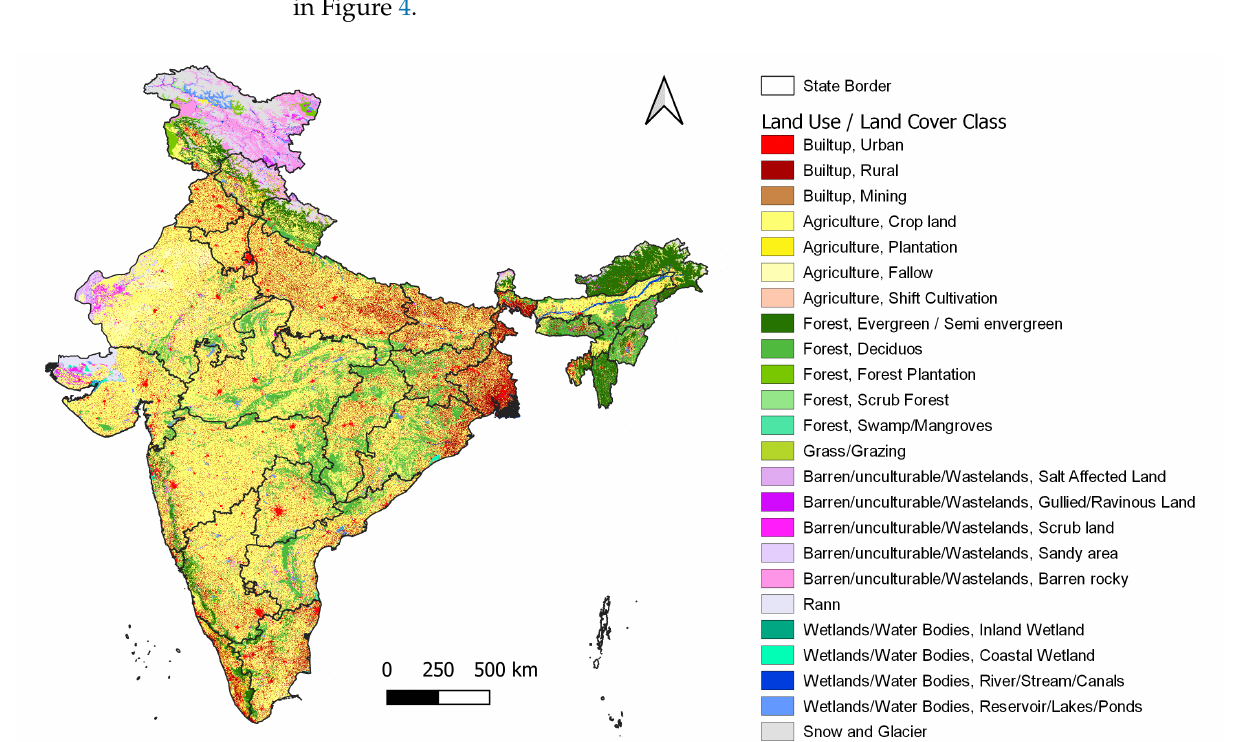
Figure 4. Land use/land cover map for India. Table 3. LCLU class definition and